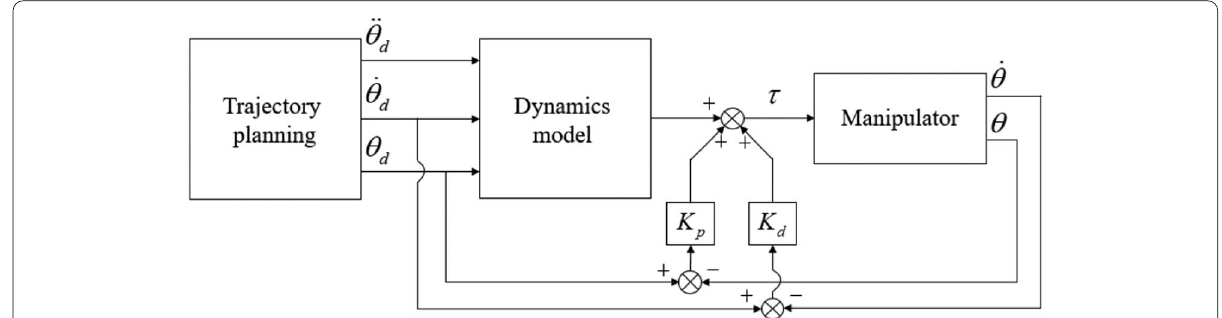
Figure 12 Block diagram of feedforward control